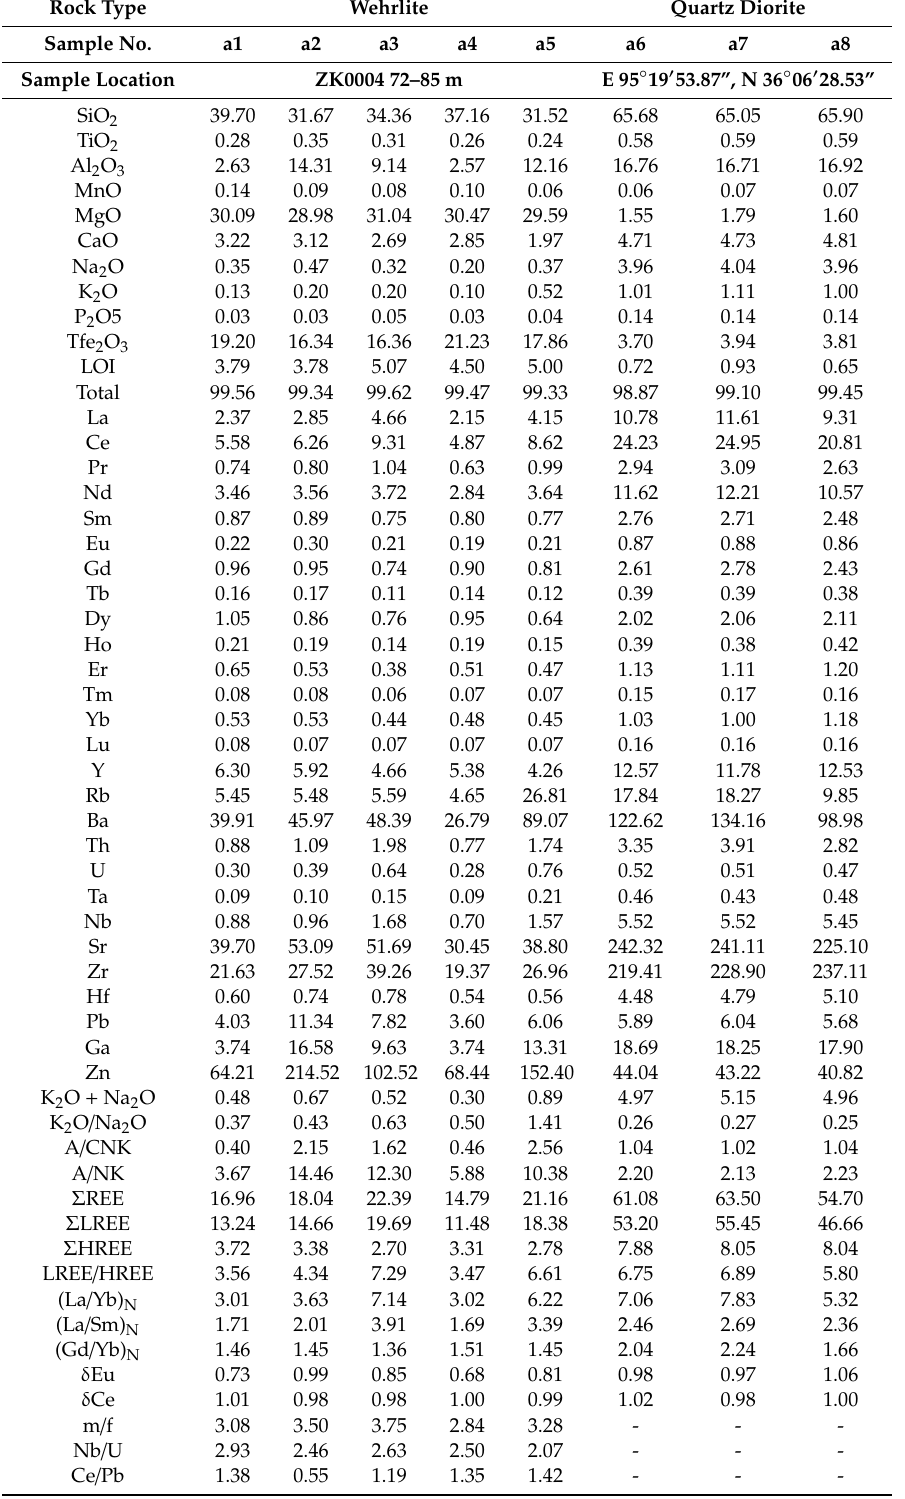
Table 2. Major elements (%) and trace elements (10 − 6 ) of wehrlite and quartz diorite. Rock Type Wehrlite Quartz Diorite Sample